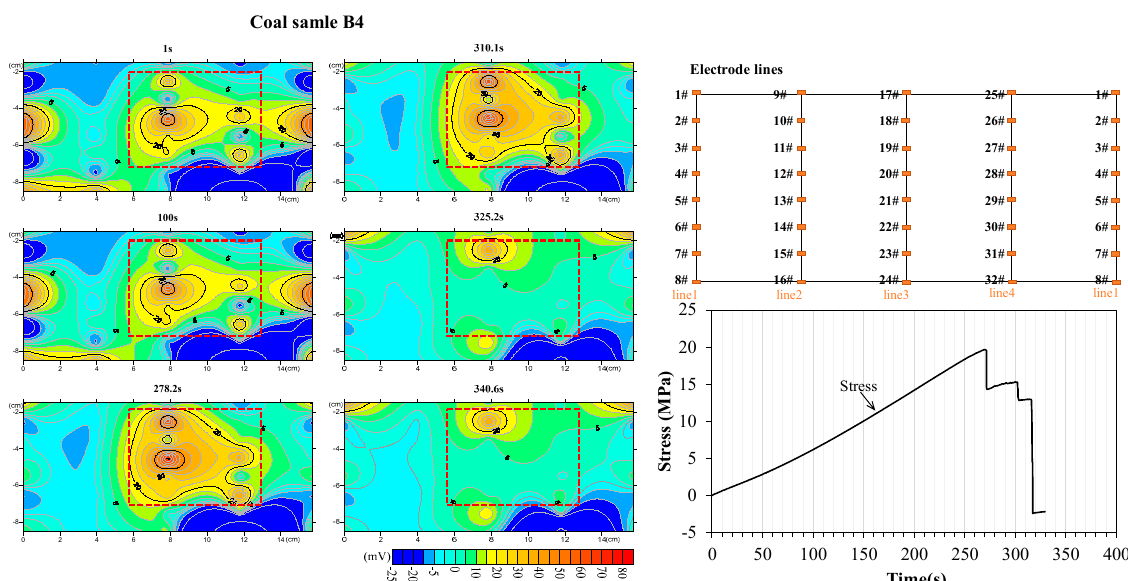
Figure 10. Profiles of the variation in self-potential with time for coal sample B4. Areas of significant change in self-potential are indicated by red dashed lines. 1#–32# stand for the electrode 1 to electrode 32.